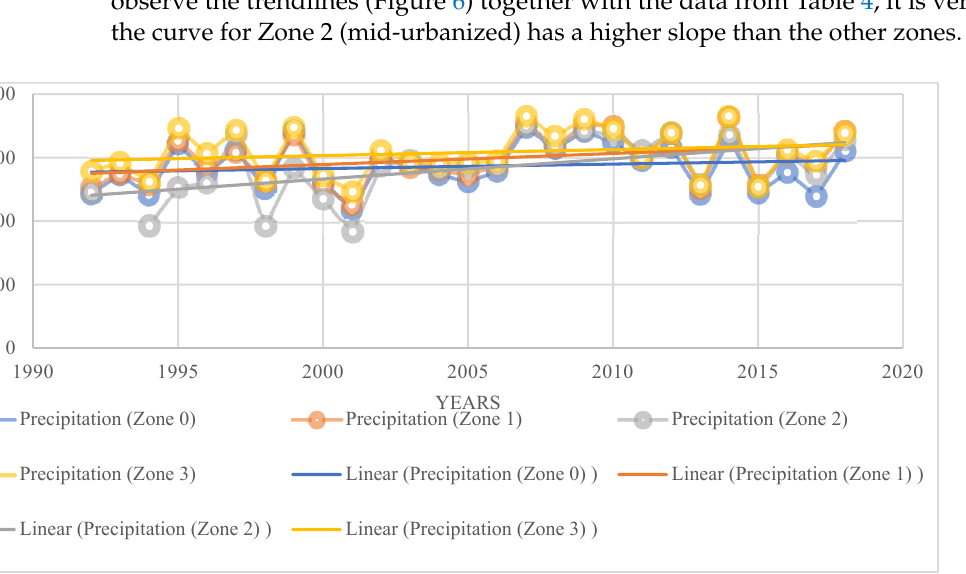
Figure 6. Regression model for yearly total precipitation based on DMSP-VIIRS nighttime light-based urban development zone. Table 4. Linear Regression Results When DMSP-VIIRS Nighttime Light is